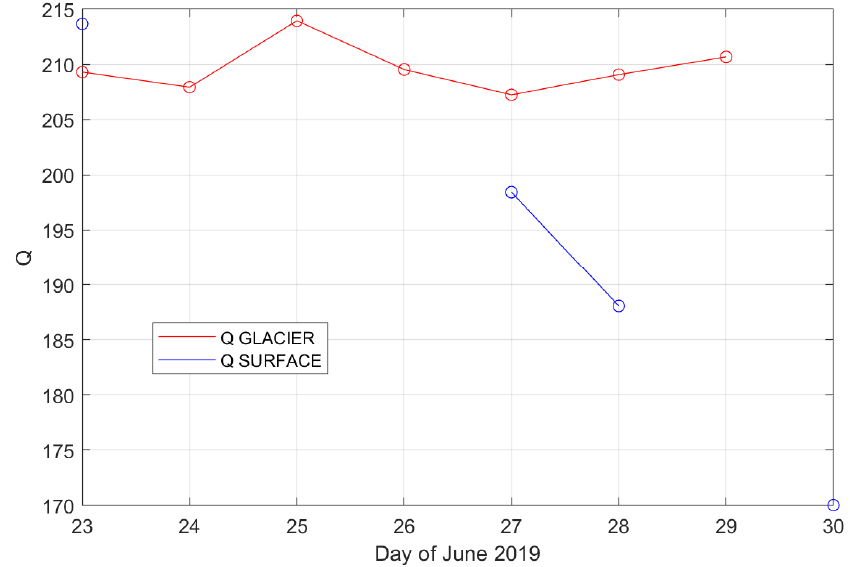
Figure 6. The calculated Q factors of the inside-glacier- and surface antennas.